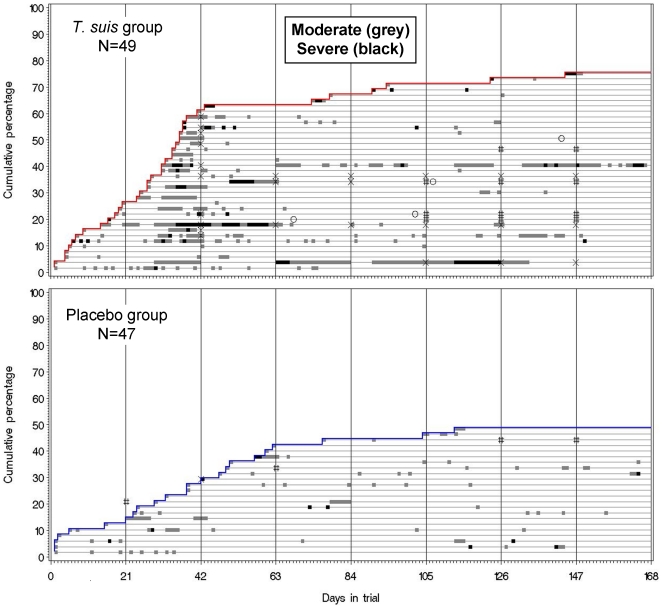
Incidence of gastrointestinal symptoms after three-weekly ingestions of infective T. suis eggs by 49 subjects, and placebo by 47 subjects, in a randomized placebo-controlled double-blinded clinical trial, Denmark 2008.Vertical lines represent days of clinic visits (three-weekly) when subjects were to ingest 2500 live T. suis eggs or placebo except on visit day 168 (total 8 doses). Each horizontal thin line represents a subject. Episodes of each subject are indicated by grey (moderate) and black (severe) horizontal thick lines. “X”, the subject ingested no eggs/placebo due to gastrointestinal symptoms; “#”,the subject ingested no eggs/placebo due to reasons unrelated to the intervention; “O”, the subject stopped recording diary of symptoms before end of trial.